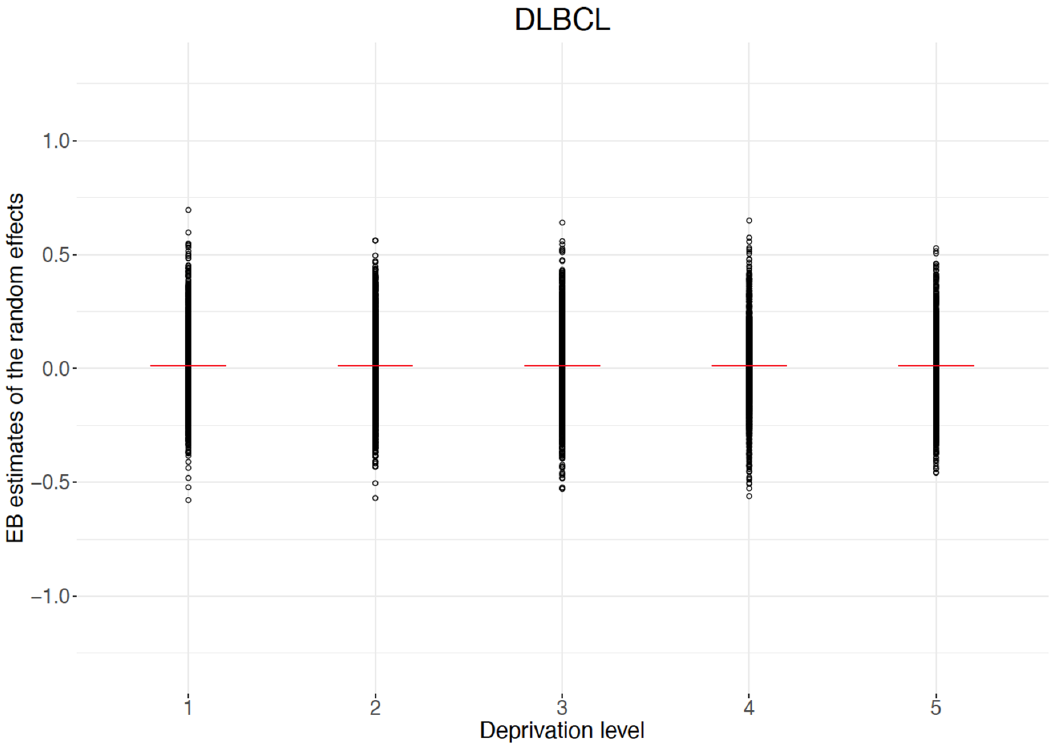
Figure A5. Empirical Bayes estimates of the random effect of LSOA from the excess mortality hazard model for patients diagnosed with diffuse large B-cell lymphoma ( n = 29,898) in England during 2005–2013.